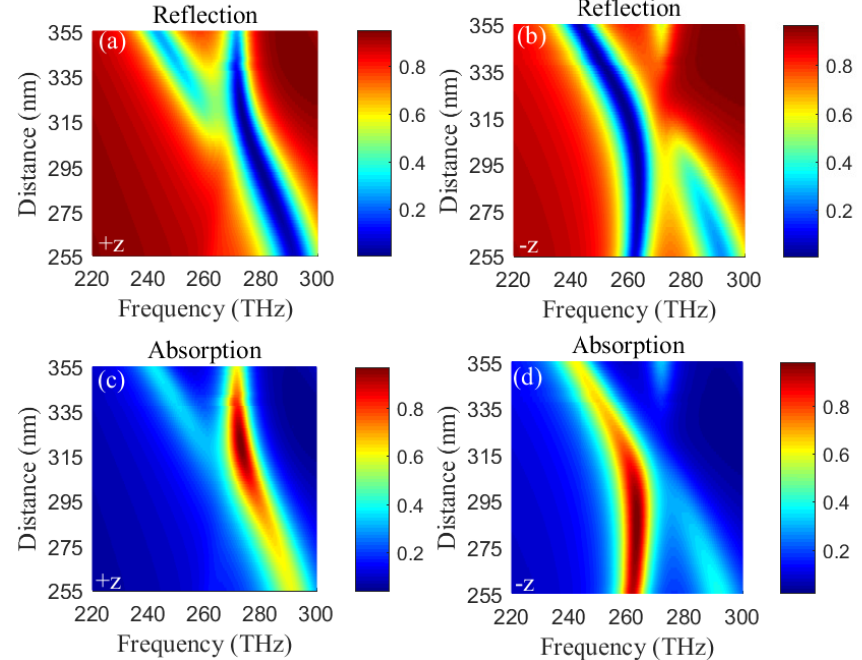
Figure 7. (Color online) Dependences of reflections (absorptions) on distance s and frequency ω in +z ( a ) and − z ( b ) (+z ( c ) and − z ( d ))